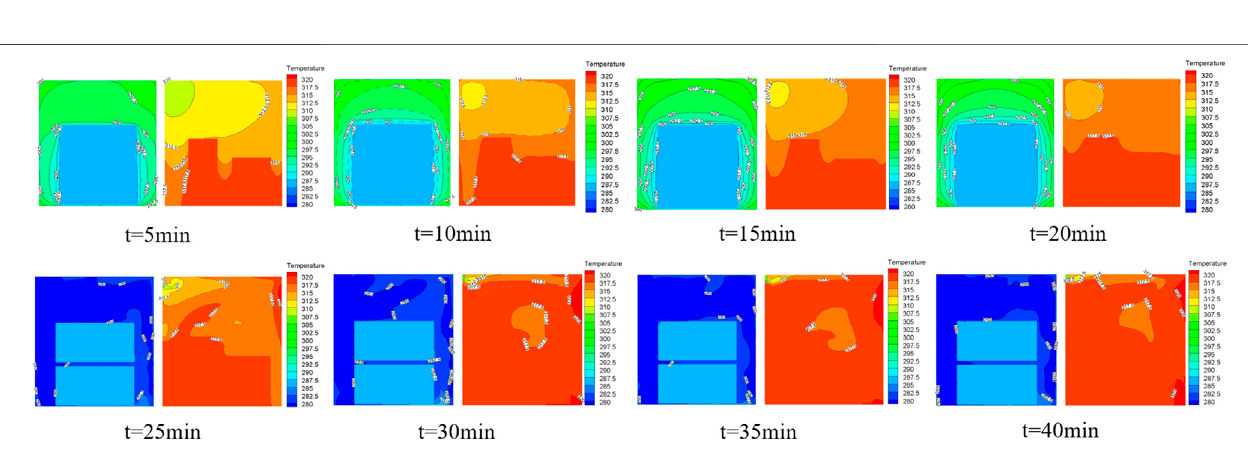
FIGURE 10 | The temperature fi eld of the compartment at y (cid:2) 0.75 m in the fi rst 40